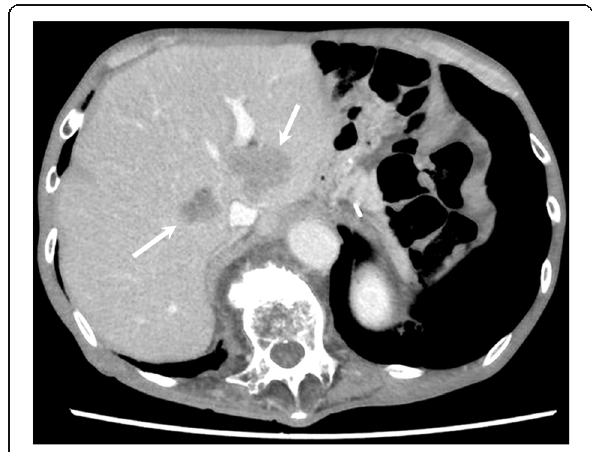
Fig. 1 Initial findings on abdominal computed tomography (CT). Abdominal enhanced-contrast CT revealed multiple liver metastases in the bilateral lobe of the liver (arrows)